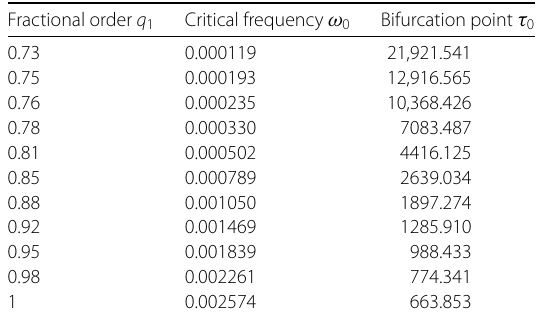
Table 4 The effect of q 1 on the values of ω 0 and τ 0 for system (29) when q 2 = 0.95